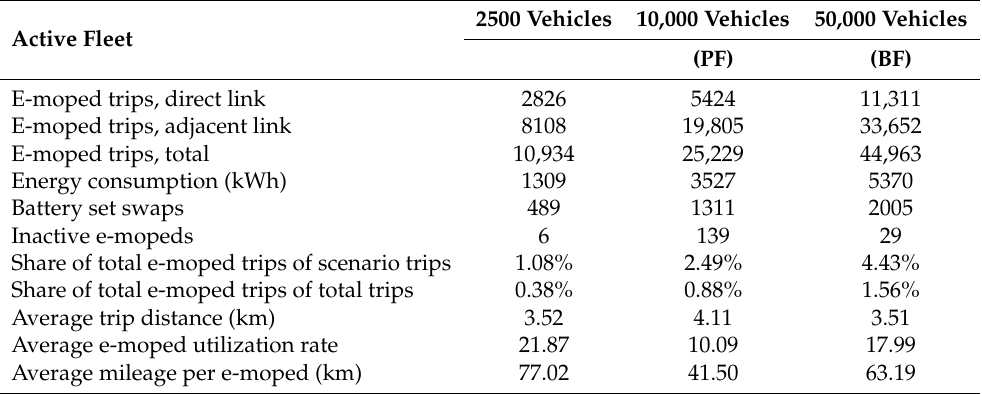
Table 11. Daily sharing simulation results for additional scenarios (PF—personal factor, BS—8 h battery swap).